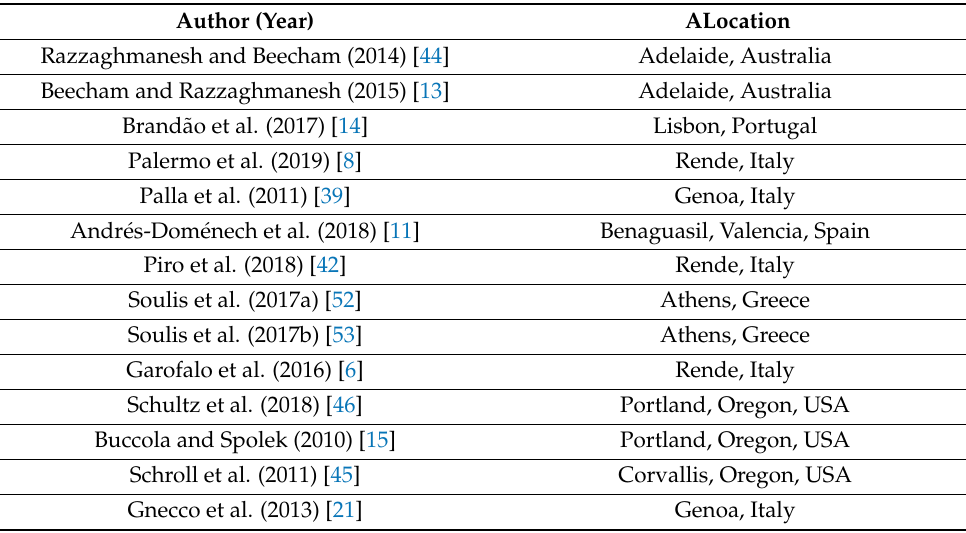
Table A8. Articles with data for the Mediterranean